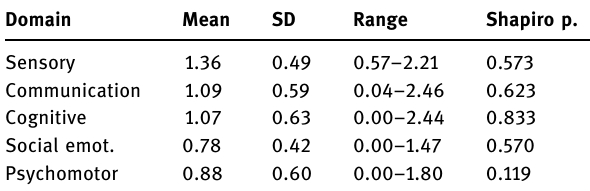
Table 7: Changes in domain scores across the